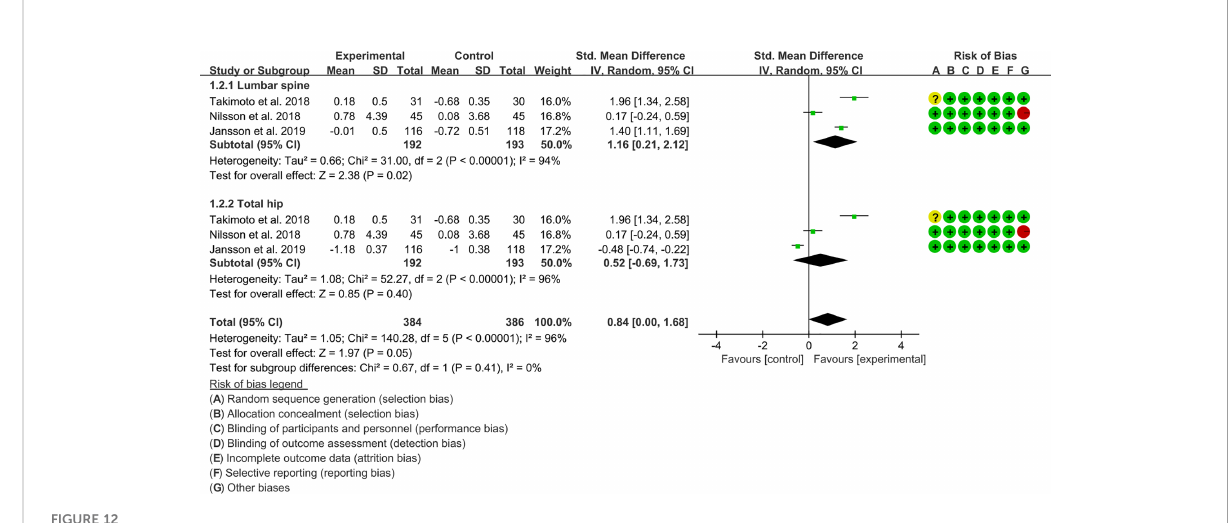
FIGURE 12 The percentage of BMD improvement (CI, con fi dence interval; SD, standard